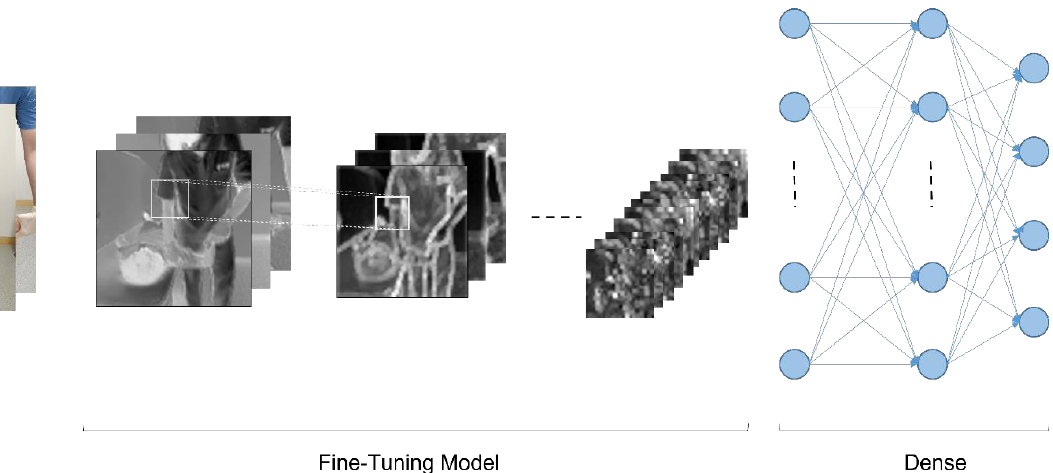
Figure 5. Basic model structure for video classifications.